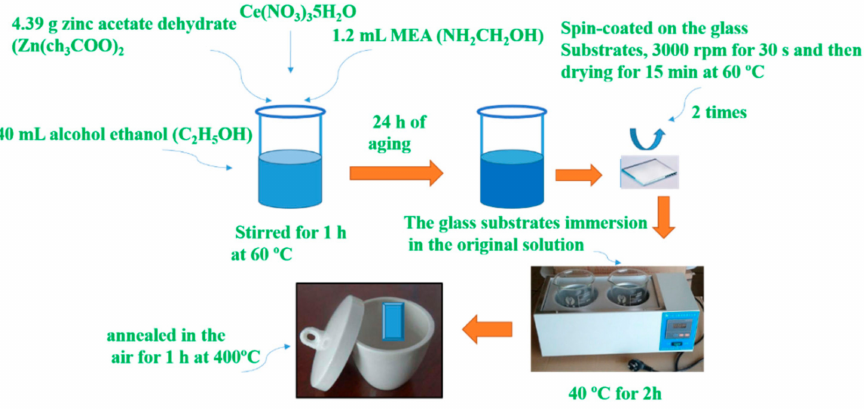
Figure 1. Schematic diagram for the deposition of un- and Ce-doped ZnO film on glass substrates.